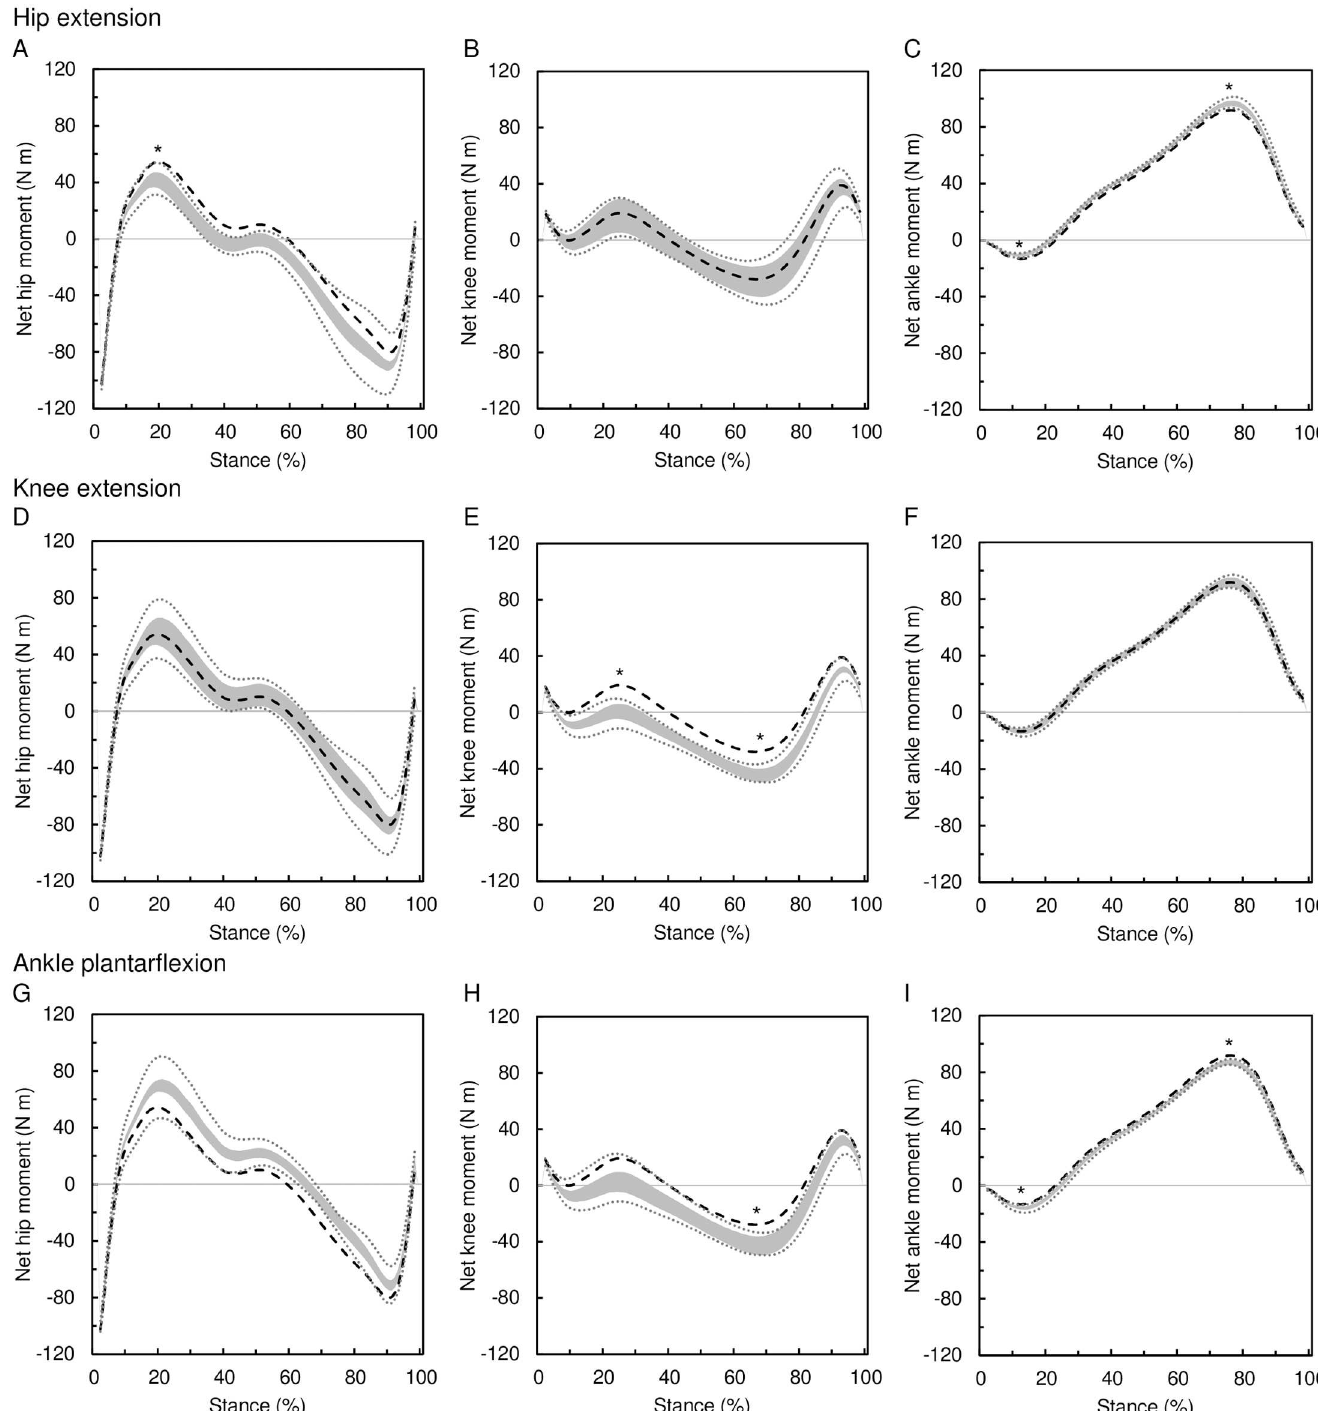
Fig 7. Effect of posture on net joint moments. The effect of hip extension(A–C), knee extension(D–F), and ankle plantarflexion (G–I) on net joint moments at the hip (A, D, G), knee (B, E, H), and ankle (C, F, I). Manipulated postures (gray area) are comparedto the originalposture (black dashed line). The gray area covers all possibleposturalchangesmeeting the followingconditions: 1) the manipulated joint changeis 8˚, 2) the change in other joints is (cid:20) 8˚, 3) Δ hip angle = Δ knee angle + Δ ankleangle.See the text for detailsand Table 2 for intervals of angle changein other joints meetingthe three conditions. The gray dotted lines represent the range of moments after posture manipulationsestimated using the mean ± 2 SDs divergent point location. The asterisk indicatesthe peak moment of the manipulated posture is different from the originalmoment regardlessof the divergentpoint location.